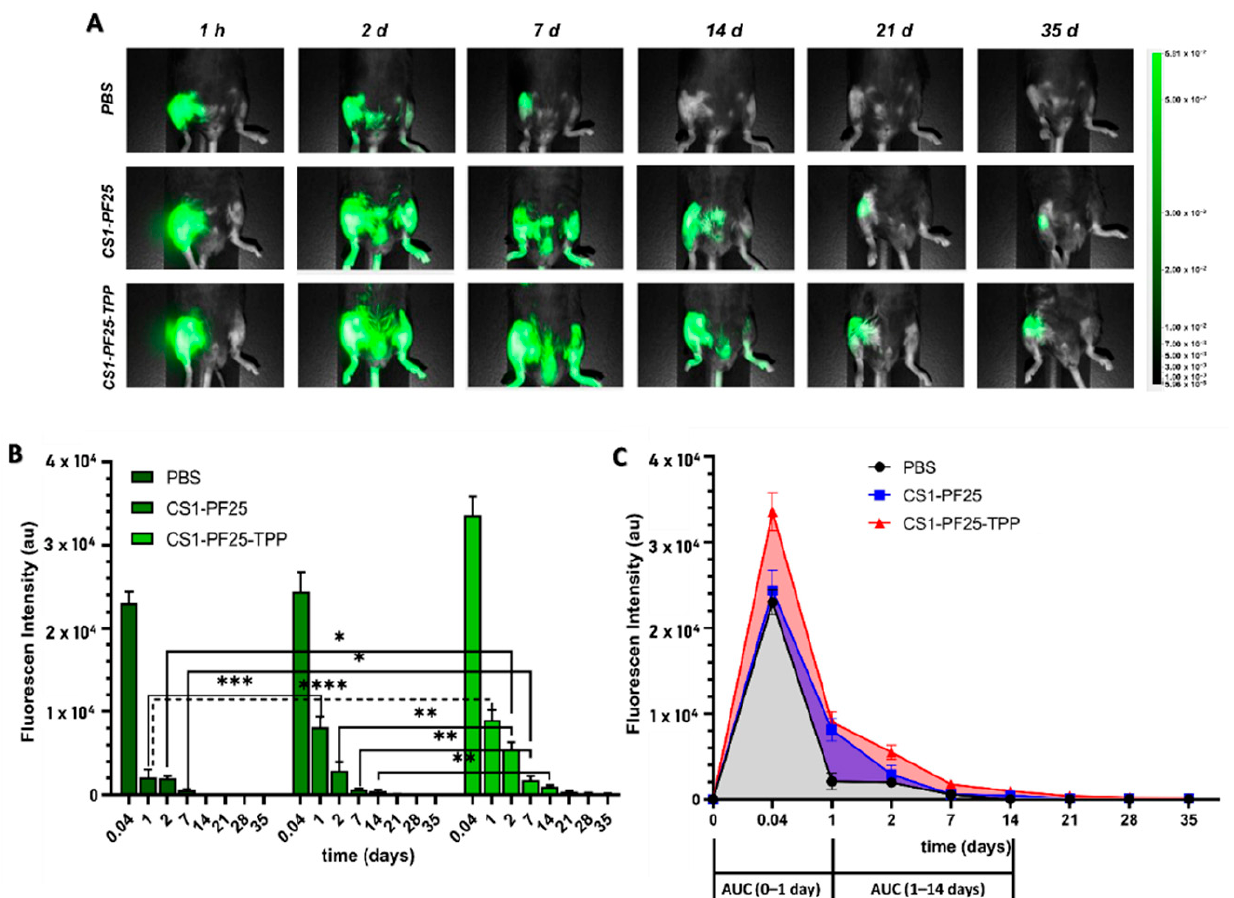
Figure 5. In vivo retention of CS-PF hydrogels: A - NIR fluorescence imaging of joint of mice taken at different times after intraarticular injection with PBS + NIR 780, CS1-PF25 + NIR 780, and CS1- PF25-TPP + NIR 780. B - In vivo retention over time of the various CS-PF hydrogels formulations indicated by relative fluorescence intensity. C - Graphic of area under the curve (AUC) of the three studied groups. Data are presented as mean ± SD. Statistical significance was determined by two- way ANOVA with multiple comparisons; * p < 0.05, ** p < 0.01, *** p < 0.001, and **** p < 0.0001.